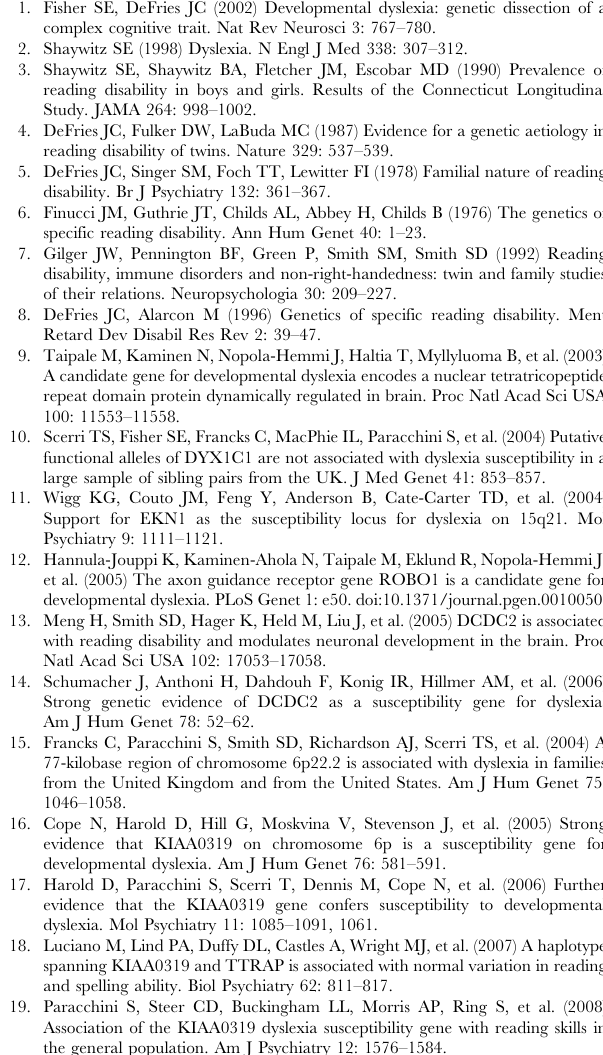
Table S4 Table S4. Marker-trait association P-values in the severe U.K. subset (126 families) - adapted from Harold et al.